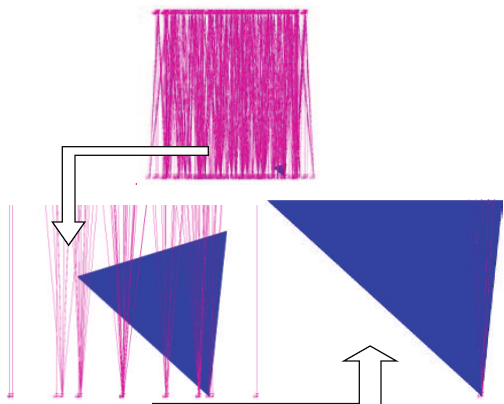
Figure 14: Problematic case of element selection viewing from z +